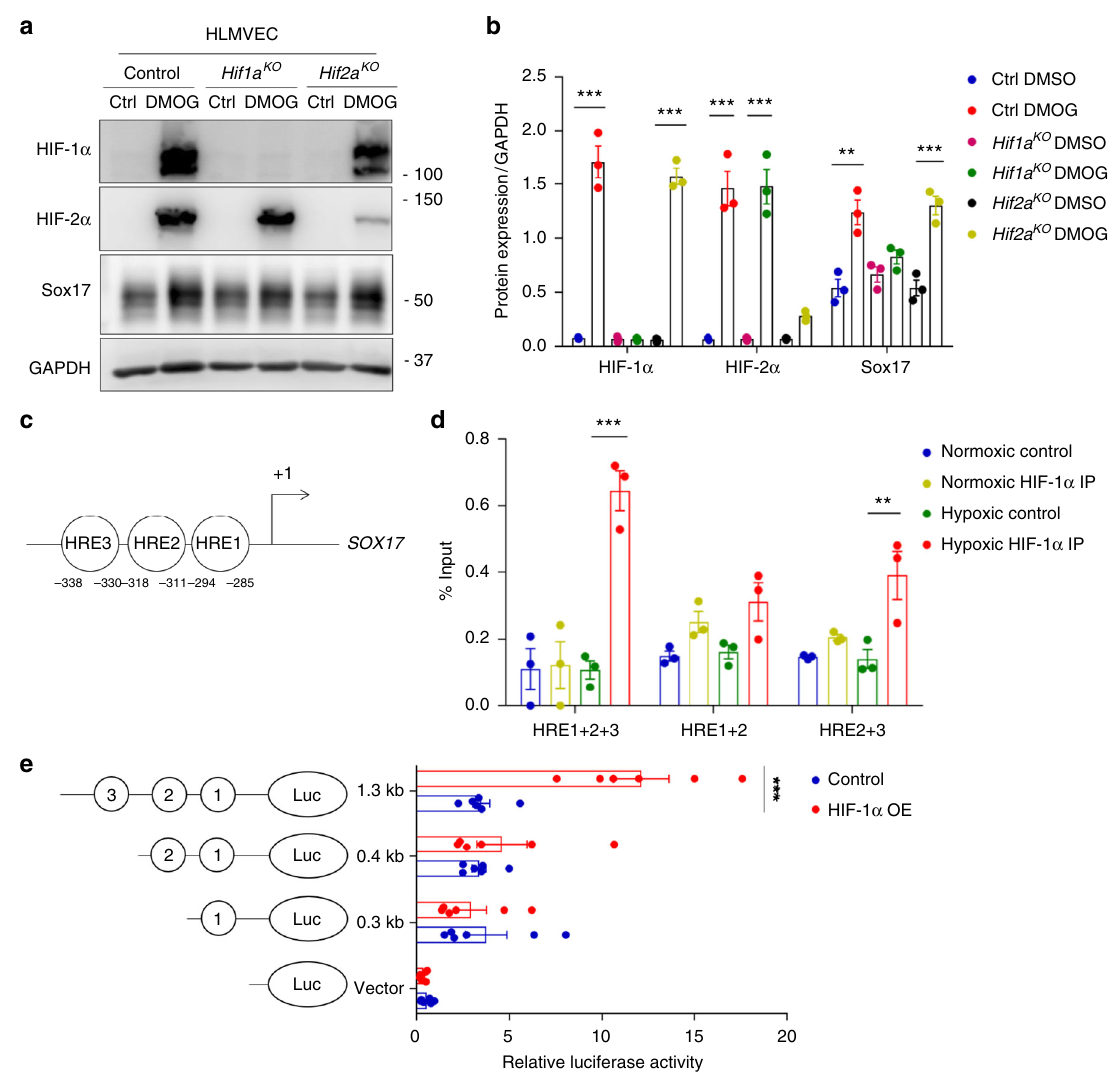
Fig. 5 HIF-1 α activates transcription of Sox17. a Western blot analysis in control HLMVECs and HLMVECs for which CRISPR/Cas9 was used to delete HIFs. ECs were treated with the HIF prolyl hydroxylase inhibitor DMOG to induce HIF expression. DMOG (1 mM) increased HIF-1 α and HIF-2 α protein expression in control ECs but not in ECs lacking HIF-1 α or HIF-2 α . Induction of HIF expression was coupled to Sox17 upregulation. n = 3. b Quanti fi cation